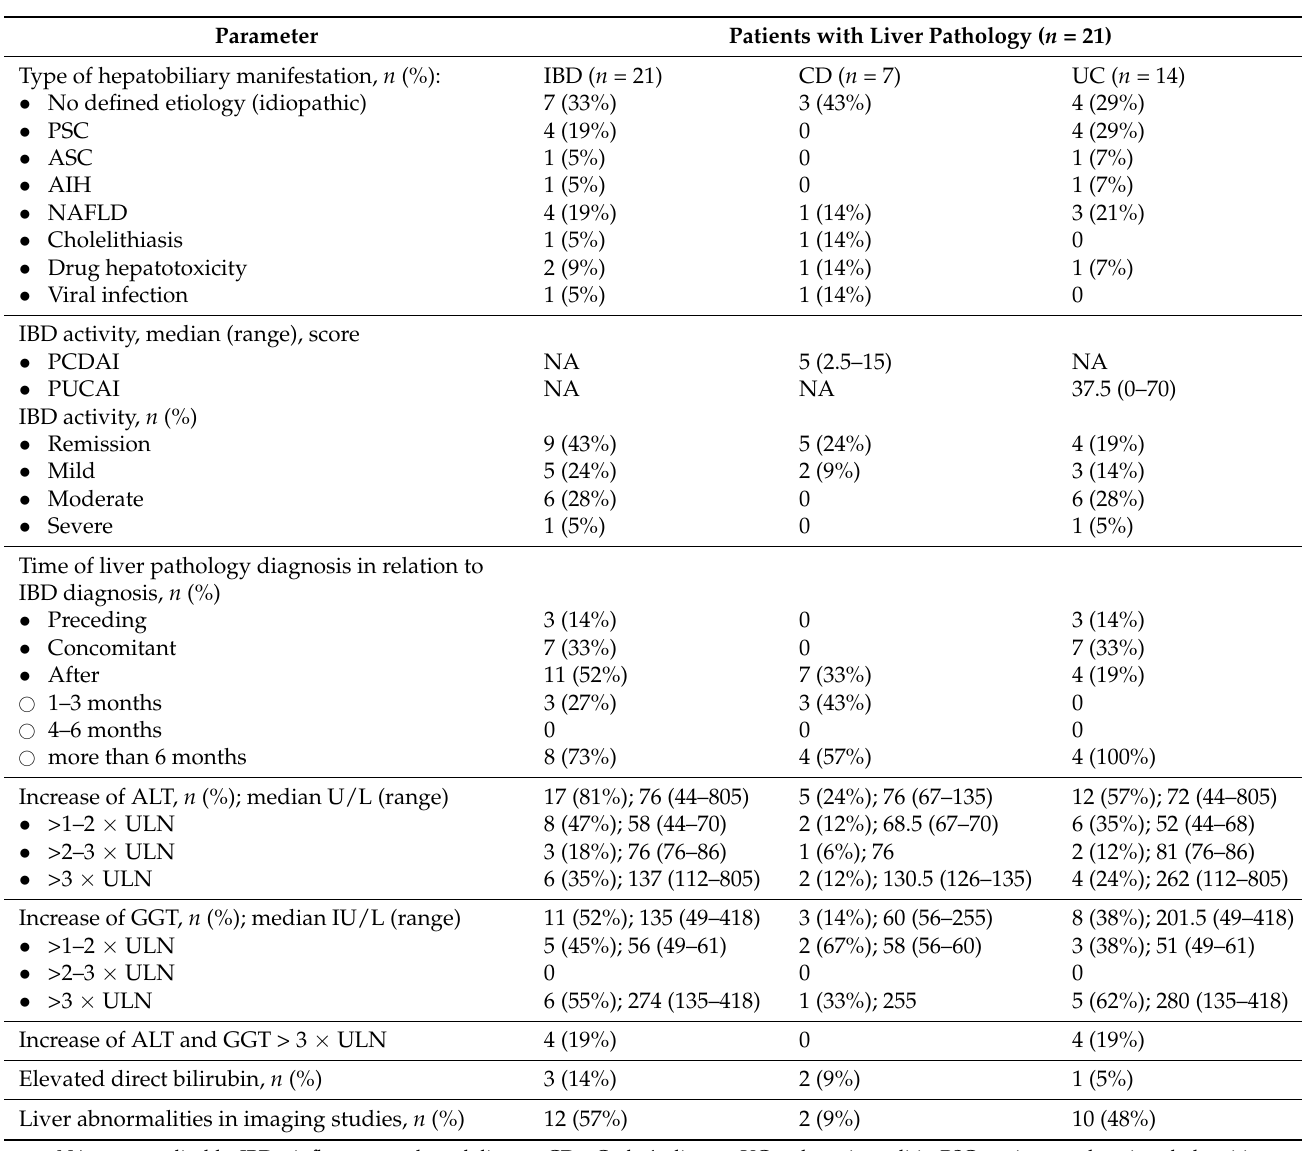
Table 2. Clinical and biochemical parameters of patients with IBD evaluated at the time of the liver pathology diagnosis. Parameter Patients with Liver Pathology ( n =